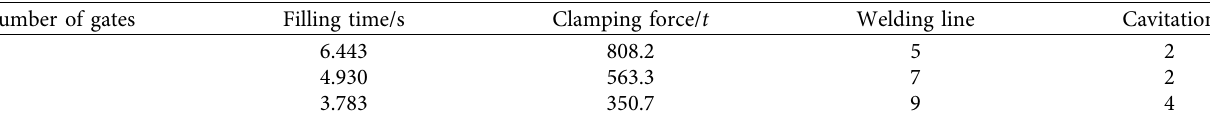
Table 1: Analysis results of three different intersection